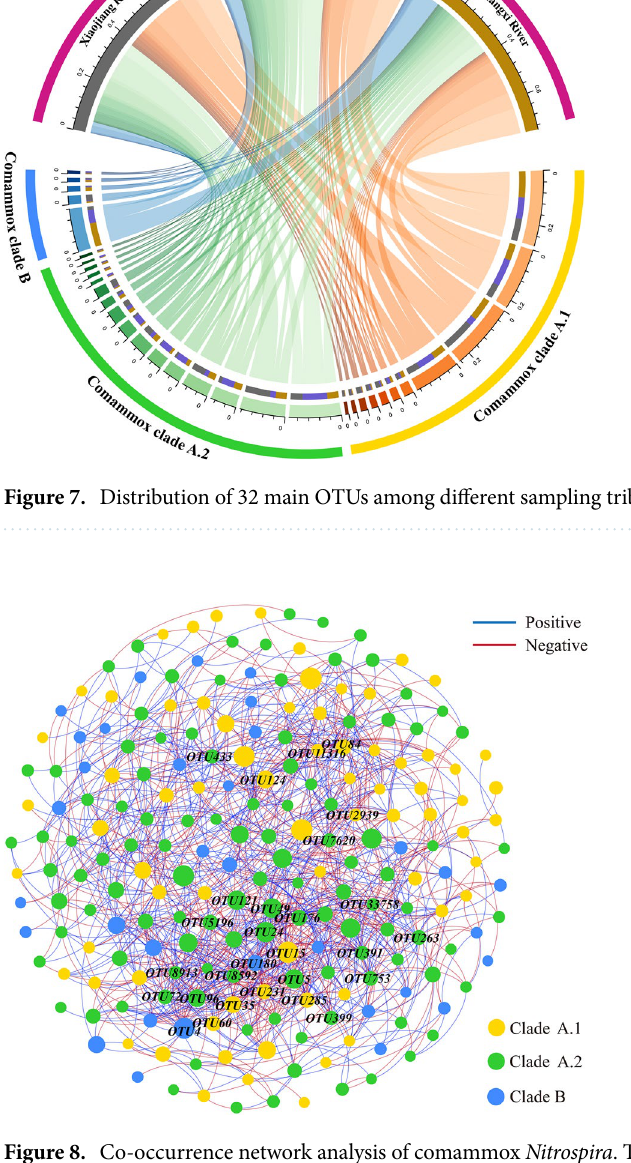
Figure 8. Co-occurrence network analysis of comammox Nitrospira . The nodes represented OTUs, the relationship between two OTUs in the network was shown by an edge. The inferred correlations were restricted to those having correlations > 0.3 or < − 0.3 ( P < 0.05, two-sided). Nodes with different colors represent different clades of comammox Nitrospira , and the size of the nodes was proportional to their relative abundance. The bule and red edges represent the positive and negative correlations, respectively, and the thickness of each edge between two nodes is proportional to the value of correlation coefficient. Hub nodes (degree > 20) were labeled in